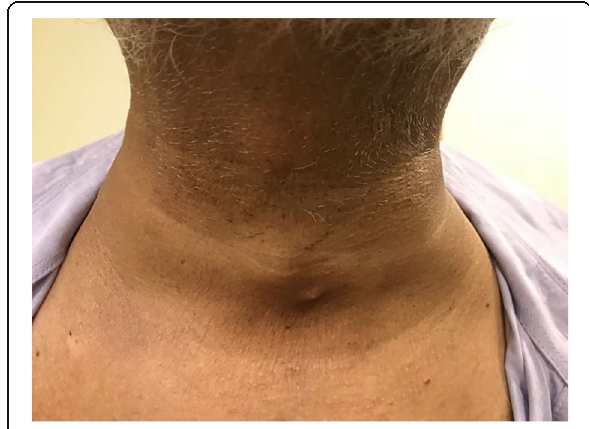
Fig. 1 Ill-defined anterior neck swelling involving midline and left side of the